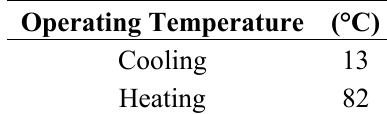
Table 2. Constant operating temperature for the temperature node T AC .